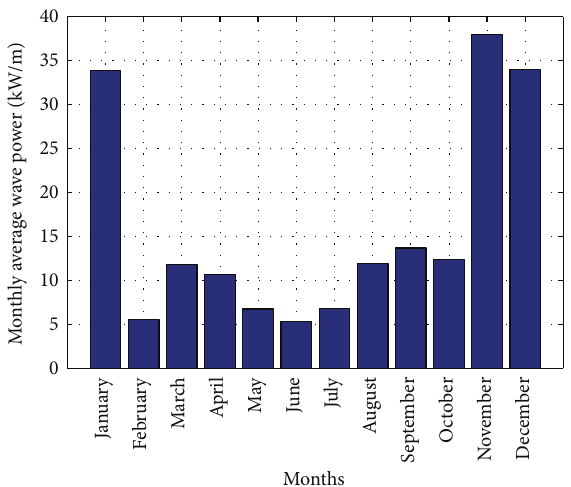
Figure 20: Average wave power level of a year for Perhentian Island.